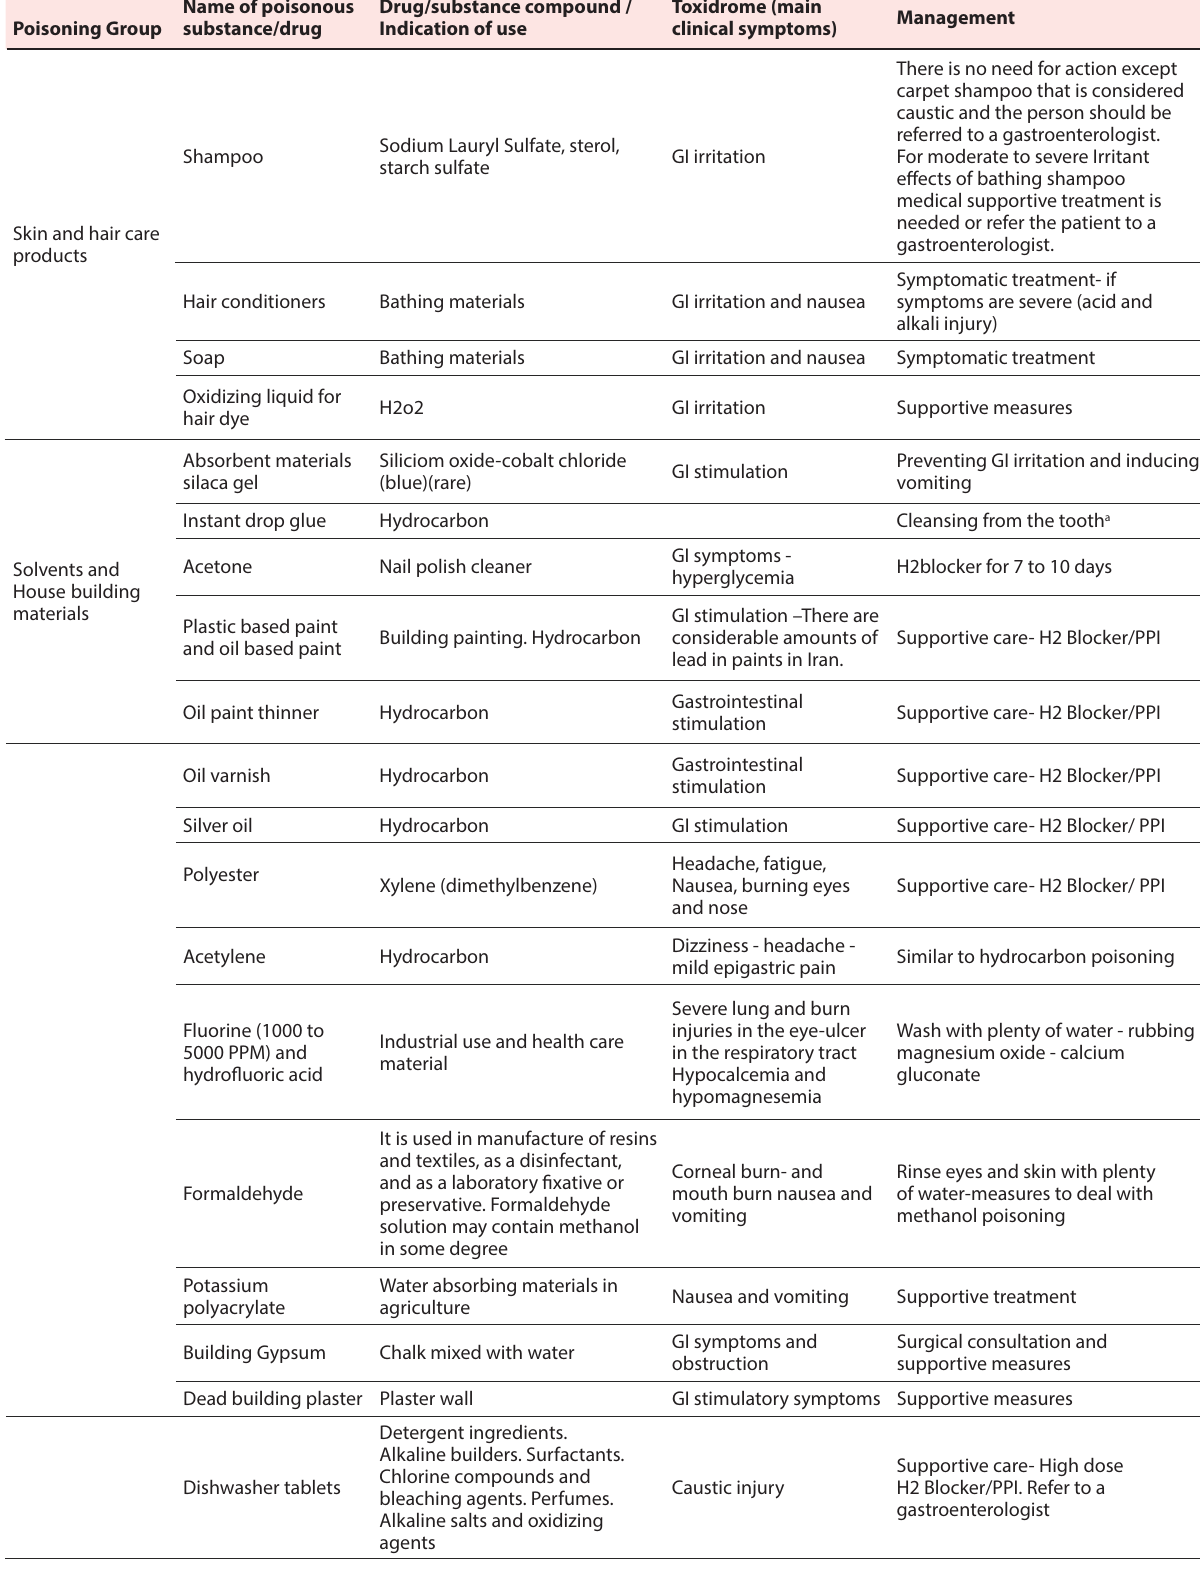
Table 1. Characteristic of some unusual poisonings in children Name of poisonous Poisoning Group